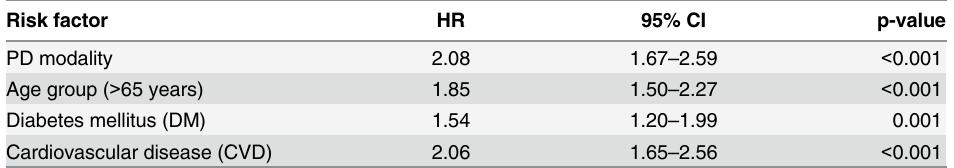
Table 2. Hazard ratios for risk of death for patients initiating PD compared with those initiating HD at 5-year follow-up.